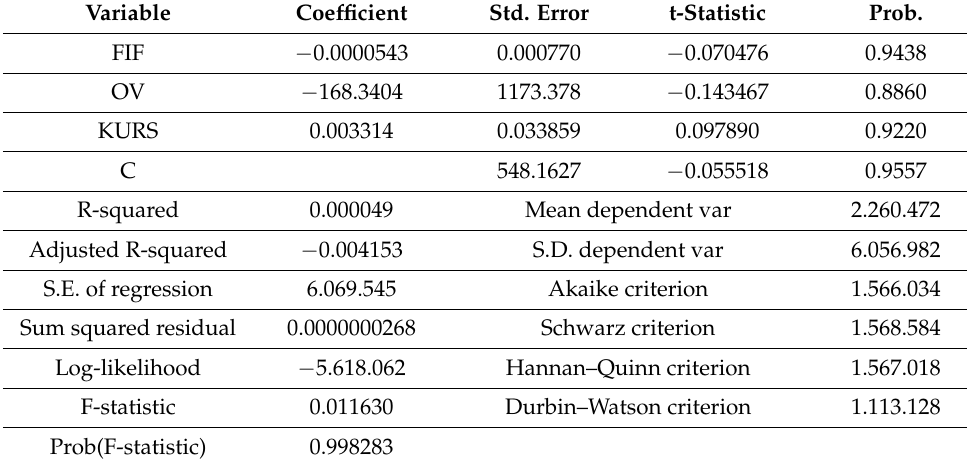
Table 19. Panel Data Regression before Lockdown.